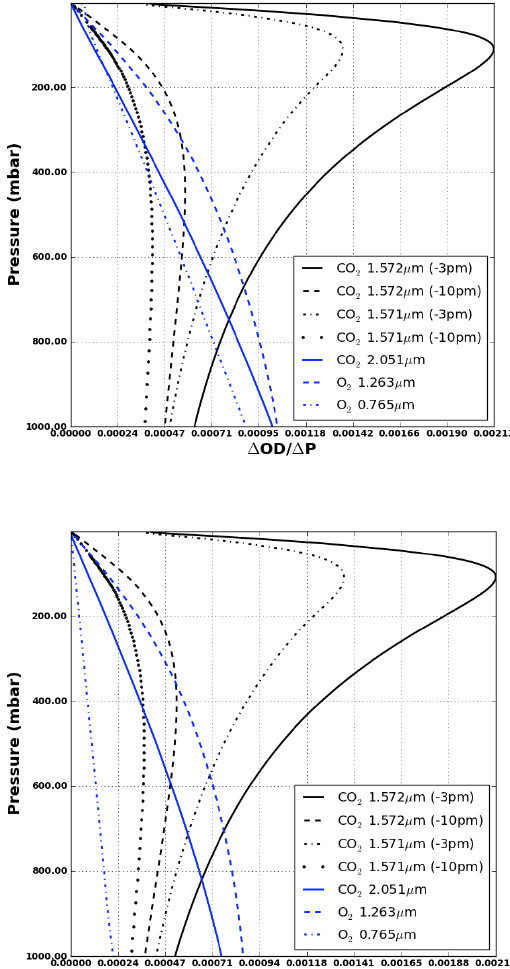
Figure 2. Ensemble mean weighting functions derived from NWP global vertical temperature and moisture profiles. The upper panel shows the average weighting function for the online wavelength only, and the lower plot shows the average weighting function for the differential optical depth calculation that uses an additional of- fline wavelength to subtract the contribution of aerosols and other scatterers. These plots show the impact of the online wavelength: the instruments sampling the 1.571 and 1.572µm with 3pm offset are sensitive to the top of the troposphere, while the 10pm offset leads to sensitivity in the mid-troposphere; the 2.05µm instrument is most sensitive near the surface, as are both O 2